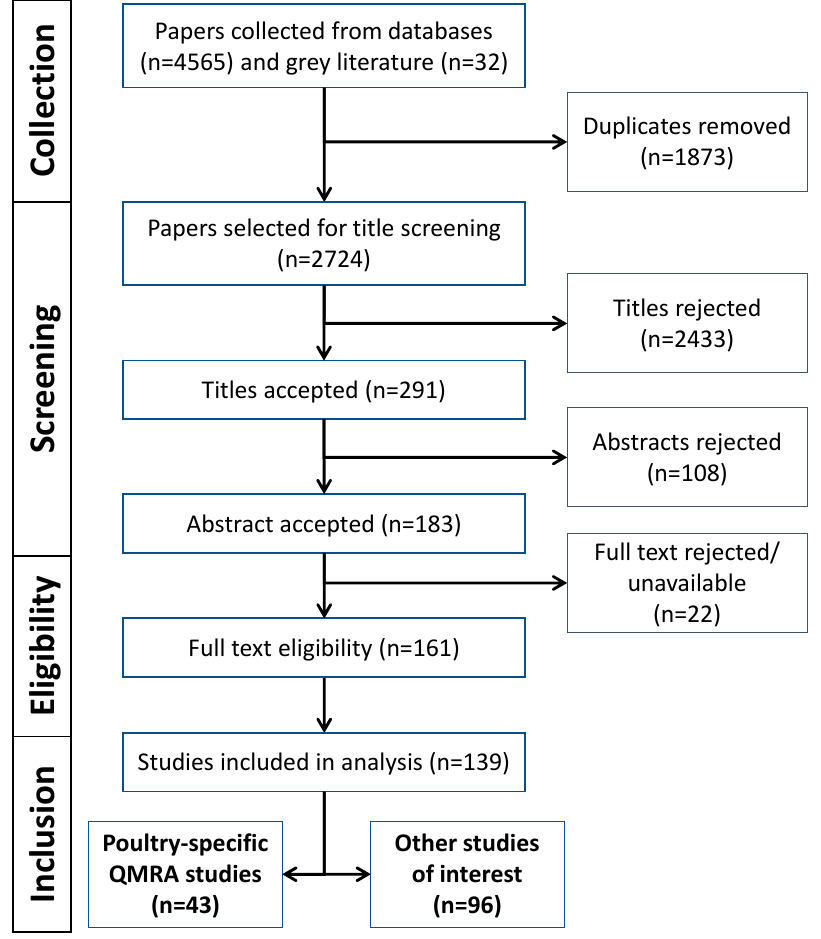
Figure 1. Flow chart of the data search process and results, based on the PRISMA diagram [11,12]. QMRA studies included in this systematic review were from Europe (23/43), covering France, the Netherlands, Germany, Finland, Sweden, Denmark, Italy, Belgium, the United Kingdom, Sweden, Denmark, Finland, Norway and Iceland); North America (10/43), covering the USA and Canada; South America (2/43), covering Chile and Argentina; Asia (5/43), covering China, South Korea, and Thailand; and one country from Africa (i.e., Senegal) (Table 1).